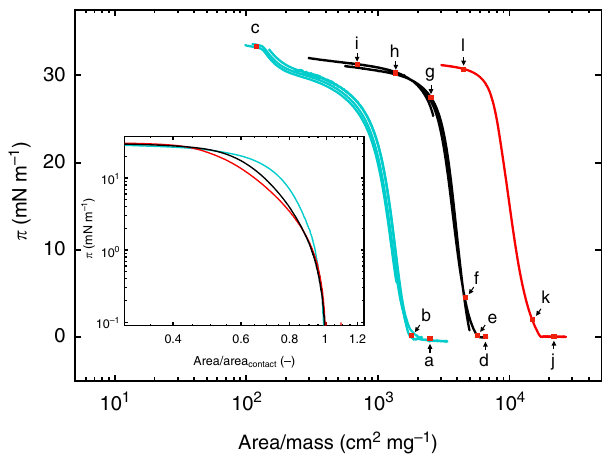
Fig. 3 Compression isotherms for linear, ultra-low crosslinked (ULC) and regular crosslinked microgels. Surface pressure, π , versus the area normalized by added mass of microgels (Area/Mass) for 5 mol% crosslinked microgels (cyan lines), ULC microgels (black lines) and linear poly( N -isopropylacrylamide) (pNIPAM; red line) at T = 20.0 ± 0.5 °C. The red squares with letters a – l indicate the π values of the atomic force micrographs in Fig. 4a – l. Inset: Plot of π versus the trough area normalized by the trough area at the contact point, Area/Area contact , of 5 mol% crosslinked microgels (cyan line), ULC microgels (black line) and linear pNIPAM (red line) at T = 20.0 ± 0.5 °C in log – log